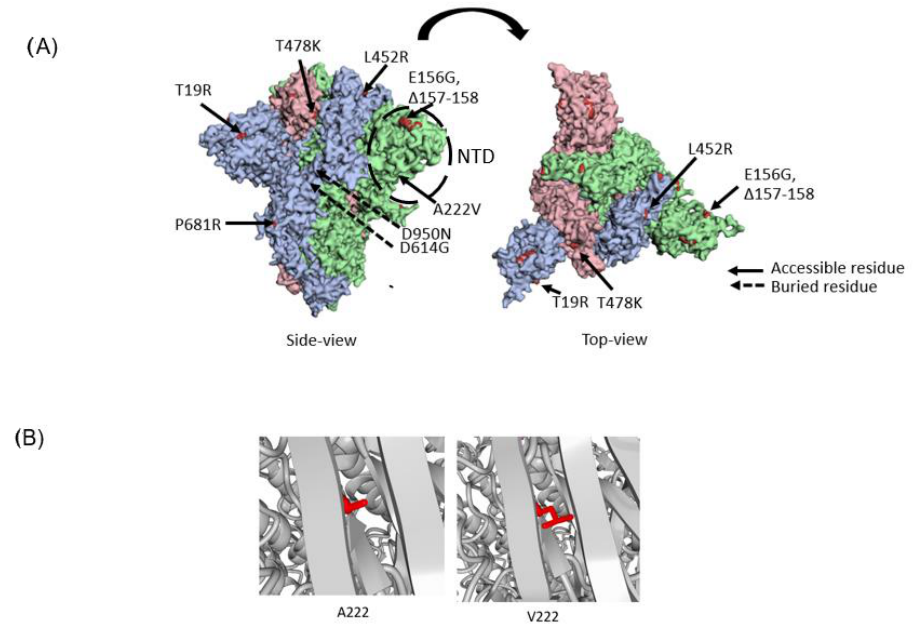
Figure 6. Structure analysis of AY.63 spike mutations. ( A ) Top and side-view of the spike protein where each subunit is colored differently (in the homotrimeric structure) with the mutations for AY.63 highlighted. ( B ) The A222V mutation visualized where alanine residue is to the left and valine on the right side.